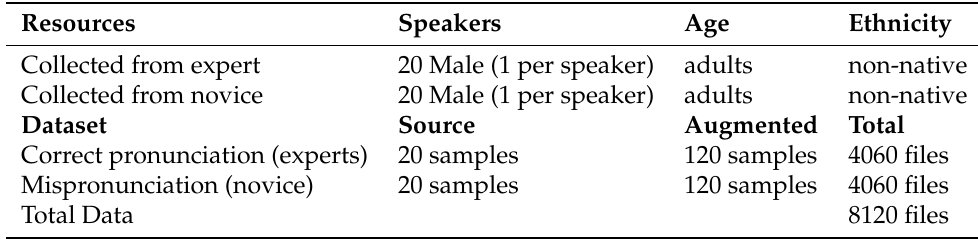
Table 3. Dataset for alphabet pronunciation